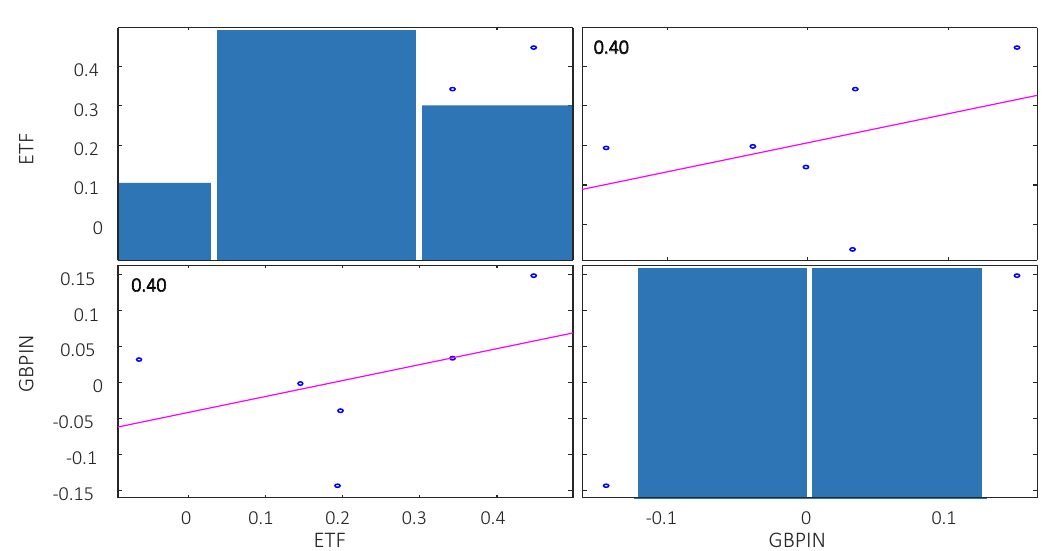
Figure 5. A matrix of plots showing the correlations between variables ETF,